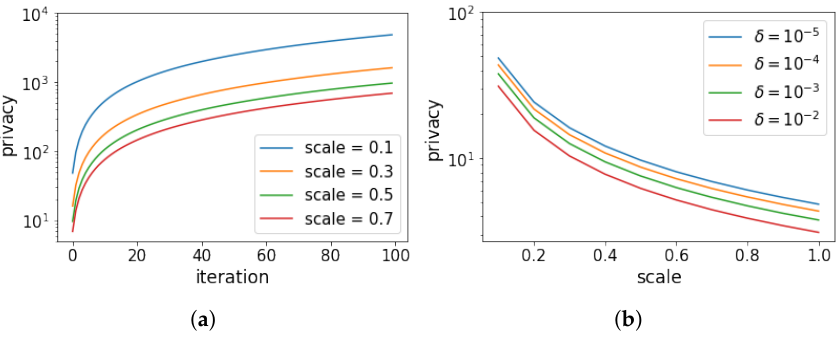
Figure 4. Privacy performance test of our DP-XGB under different parameters. Sub-figure ( a ) rep- resent the privacy budgets with increasing iterations under different scale parameters, δ = 10 − 5 . Sub-figure ( b ) represents the privacy budgets with increasing scales under different failure probabili- ties when the number of iterations is 100.